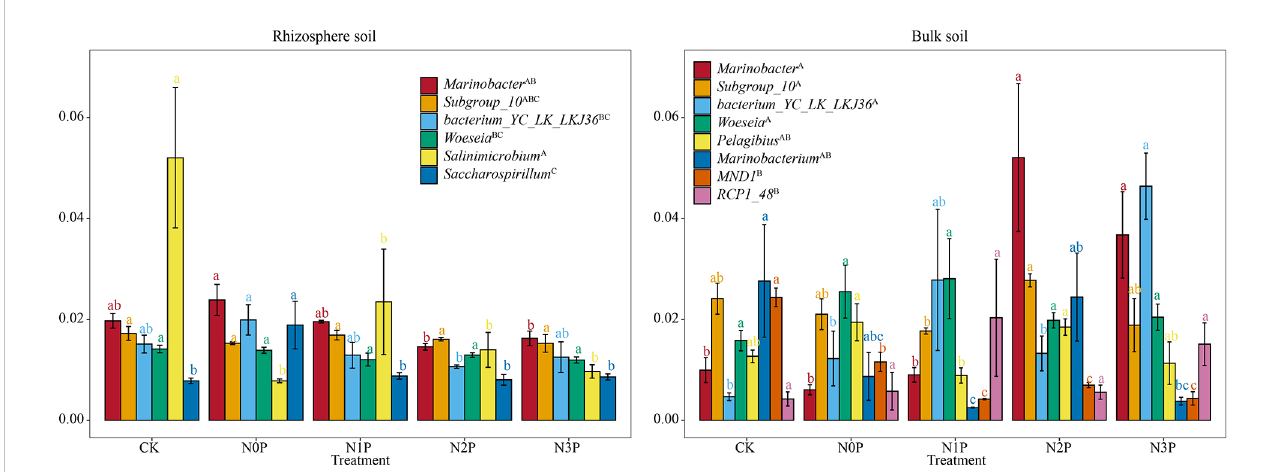
FIGURE 4 The relative abundance of dominant bacterial genus in the rhizosphere and bulk soil of S. salsa at different N-P addition ratio treatments. Different capital letters indicate that the difference among dominant bacterial genus is signi fi cant (P<0.05). Different lowercase letters indicate that the difference among N-P addition ratio treatments is signi fi cant (P<0.05).